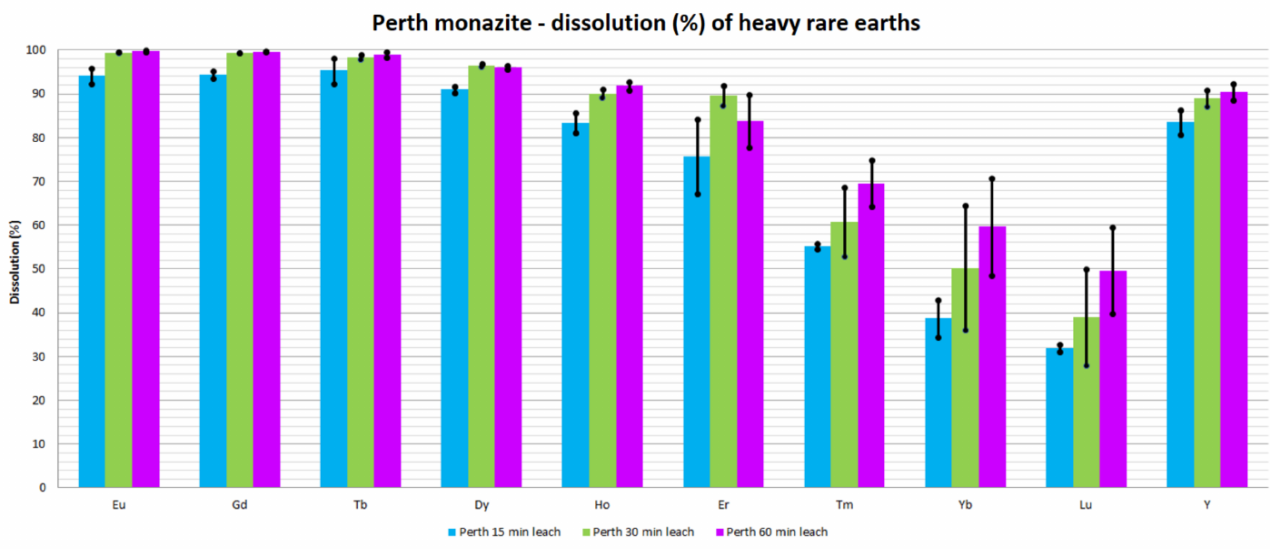
Figure 3. Heavy rare earth dissolution in leach: Perth monazite (260 ◦ C leach, 215 g/L